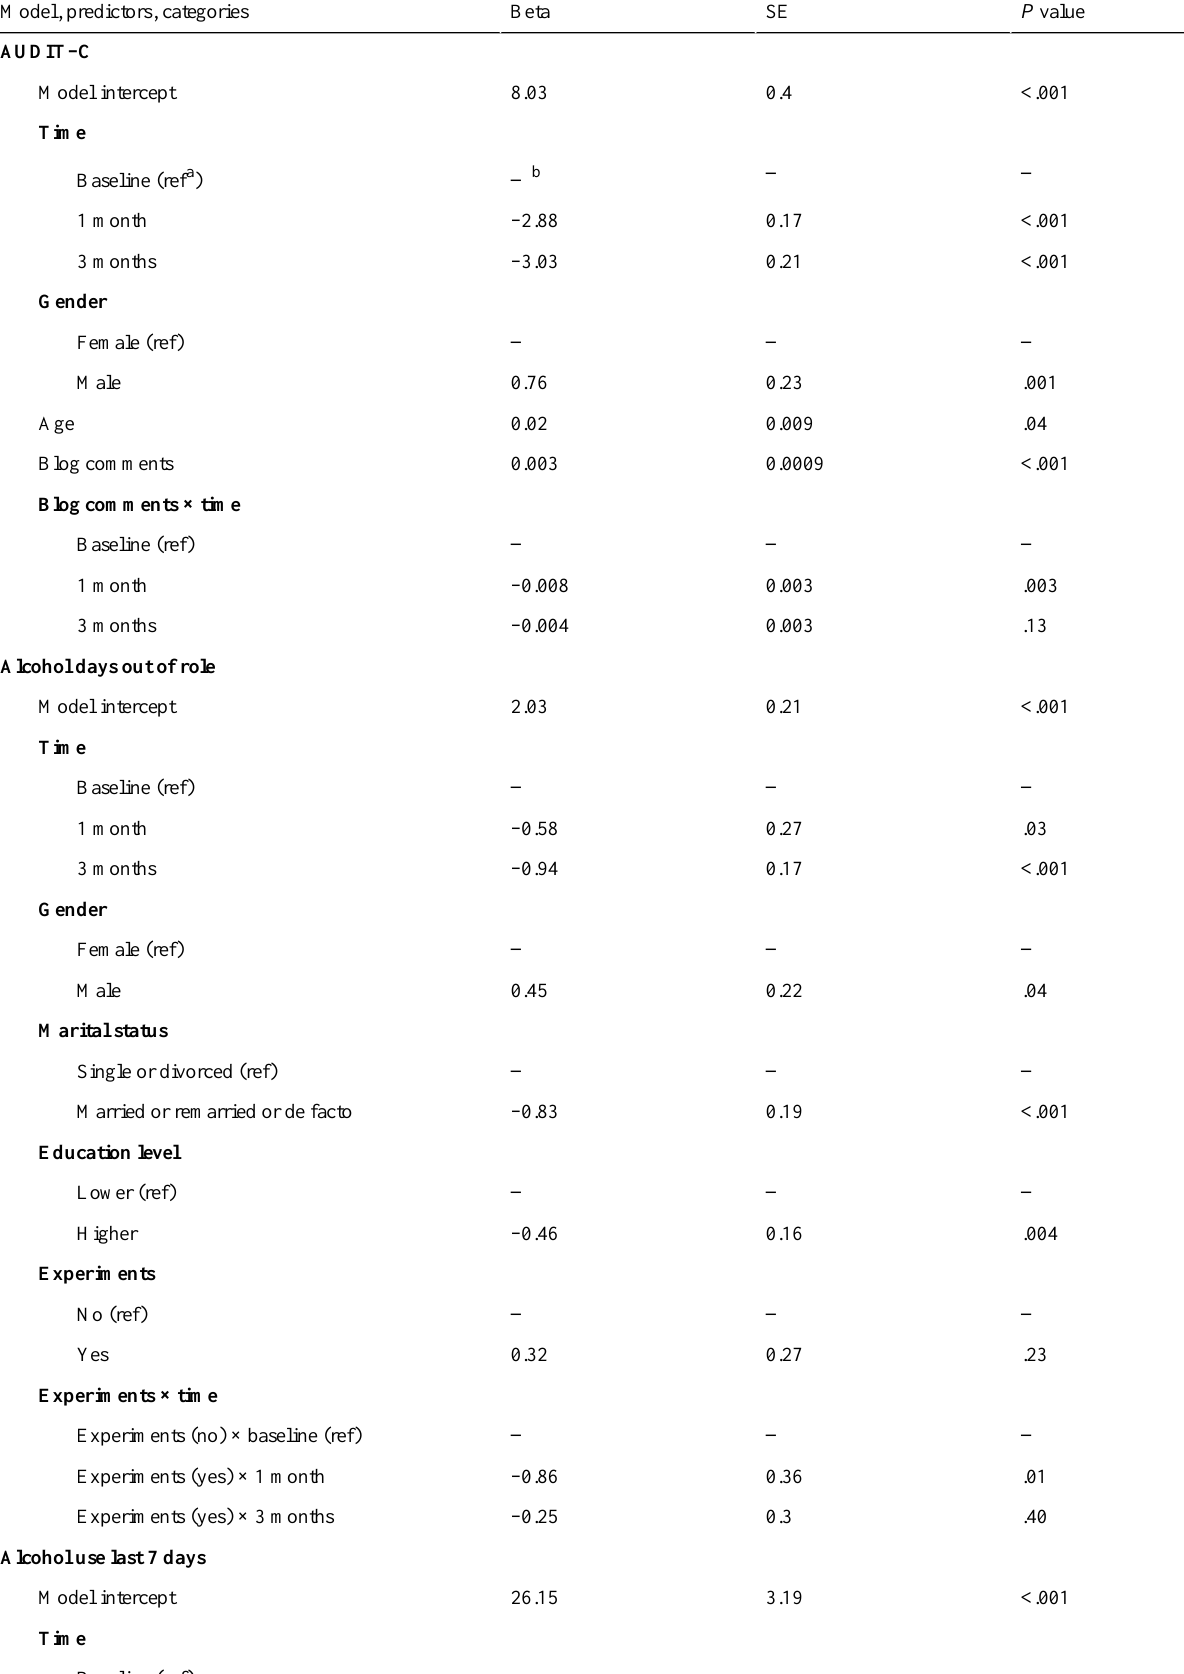
Table 4. Factors relating to change in alcohol use disorders identification test (AUDIT–C), alcohol days out of role and alcohol use (last 7 days) for all participants (Weighted Generalized Estimating Equation